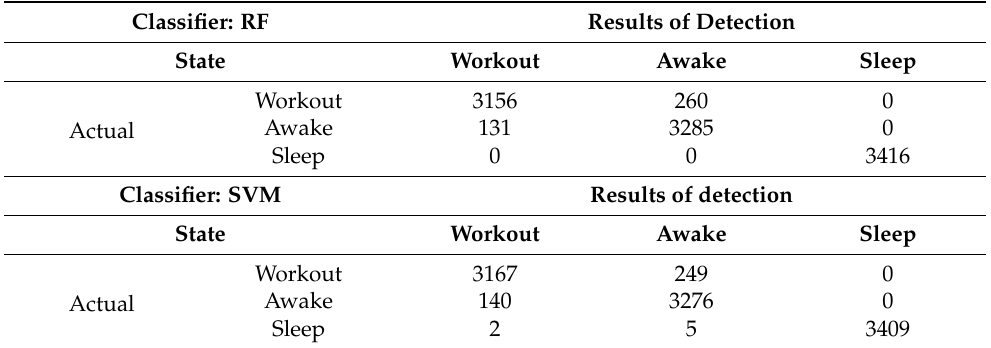
Table 3. Confusion matrix for random forest and SVM.